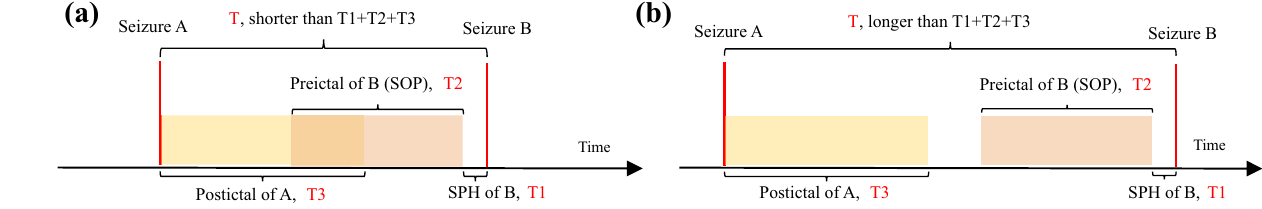
Figure 3. Different time intervals between two seizures: ( a ) There is an overlap between postictal and preictal, ( b ) No overlap between postictal and